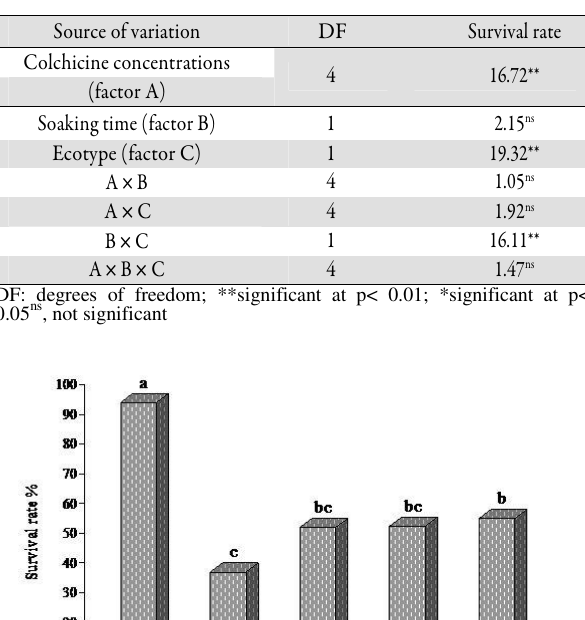
Tab. 1. Analysis of variance for survival rate and tetraploidy